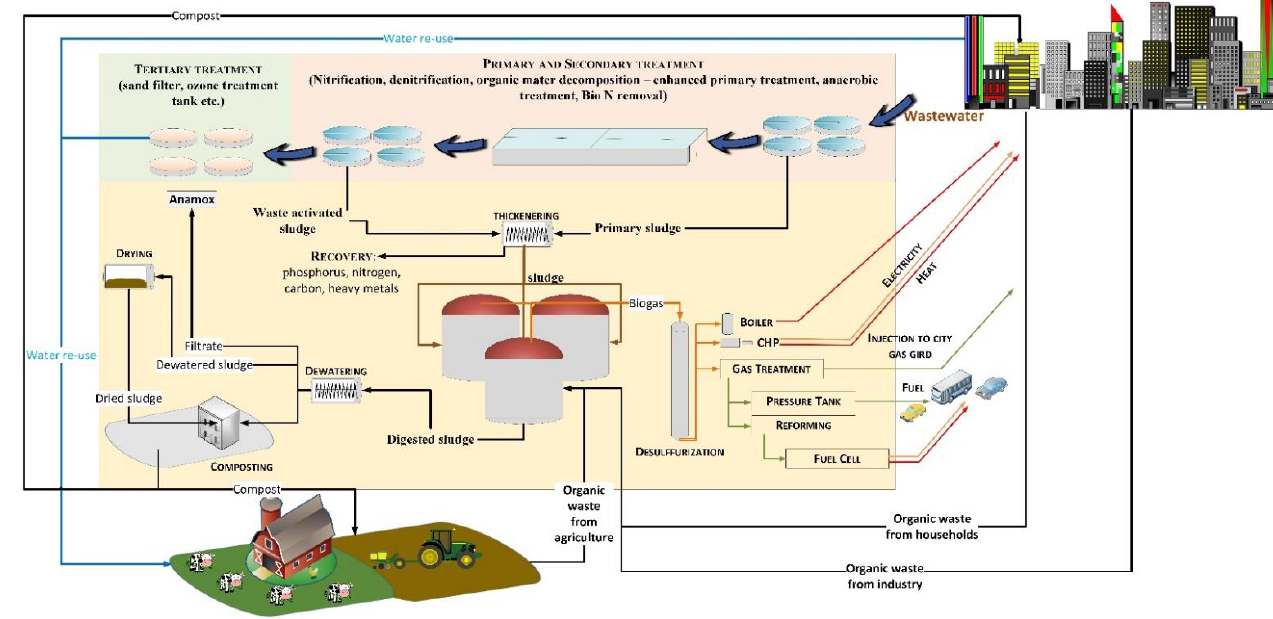
Figure 1. WWTP in the Circular Bioeconomy Concept.